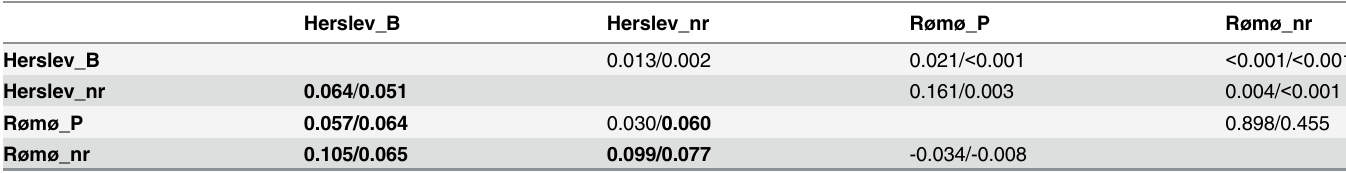
The observed/expected ratio of CpG sites was calculated from the P . elegans draft transcrip- tome to look for signatures of intragenic DNA methylation in this species. Low CpG o/e ratio is interpreted as a sign of high persistence of (germline) methylation, whereas a high CpG o/e ratio is expected for genome regions or genes with low historical methylation (e.g. [43, 44]). Species completely lacking or having low methylation in the germline typically show a high CpG o/e ratio ( > 1). In P . elegans , the distribution of CpG o/e in predicted ORF containing con- tigs shows a unimodal distribution with an overall mean of 0.669 (Fig 1). For comparison, the probability density function for GpC o/e ratio was calculated. A unimodal normal distribution with mean approaching 1 was observed (mean = 0.960), indicating that the CpG depletion observed in P . elegans is likely due to presence of DNA methylation and that the distribution of GpC o/e is not affected by possible biases in the G+C content of the contigs. In addition, the ratio of observed and expected TpG dinucleotides shows a significant negative correlation with CpG o/e (r = -0.44, P < 2.2e-16), indicating that depletion of CpG dinucleotides is associated with an increase in TpG dinucleotides (mean for distribution of TpG o/e ratio was 1.318). Since the mean CpG o/e value seen in P . elegans transcripts is less than 1, we can conclude that methylation is present and has left an evolutionary footprint in the genome. Table 2. Pairwise AMOVA estimations ( Φ ST /PhiPT) between all